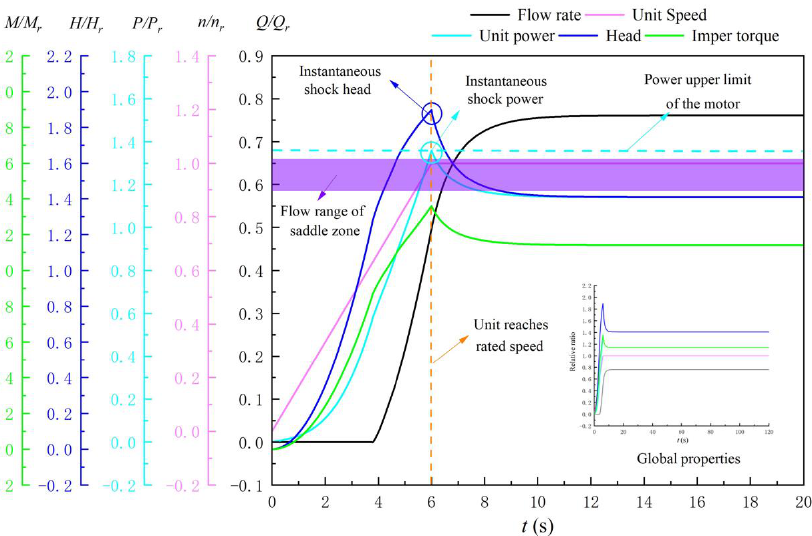
Figure 19. Start-up characteristic curves of LAPS equipped with OVHO (1.15 H m ) and FLVA (7.5% A g ) under gate refusal working conditions.